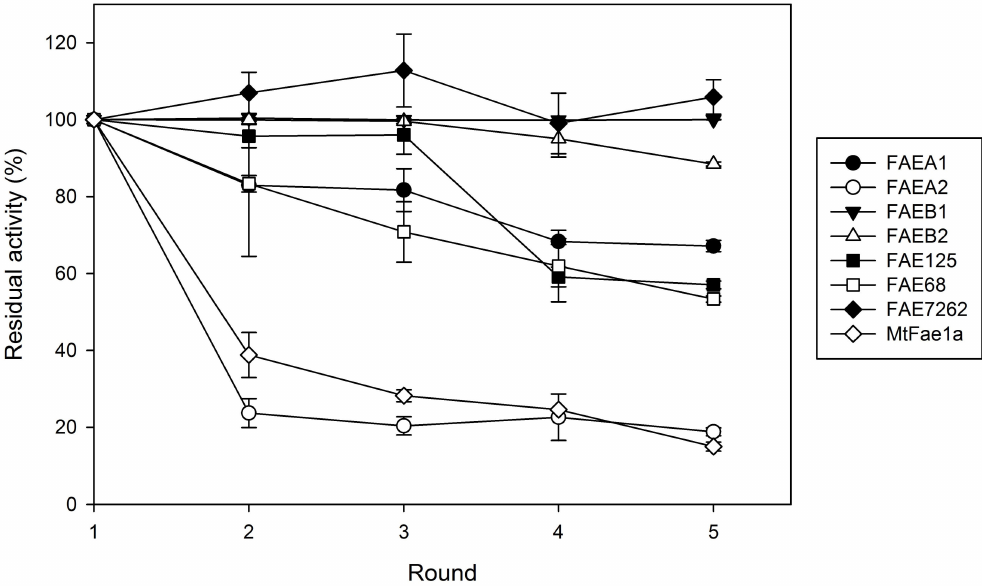
Figure 5. Operational stability of the obtained CLEAs. The residual activity is expressed as a percentage of product yield determined in the first round of